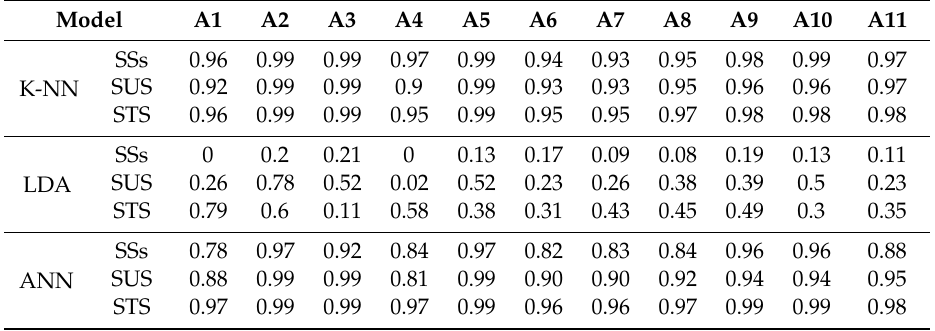
Table 4. F-scores obtained for each activity using di ff erent classification models at the group level. Model